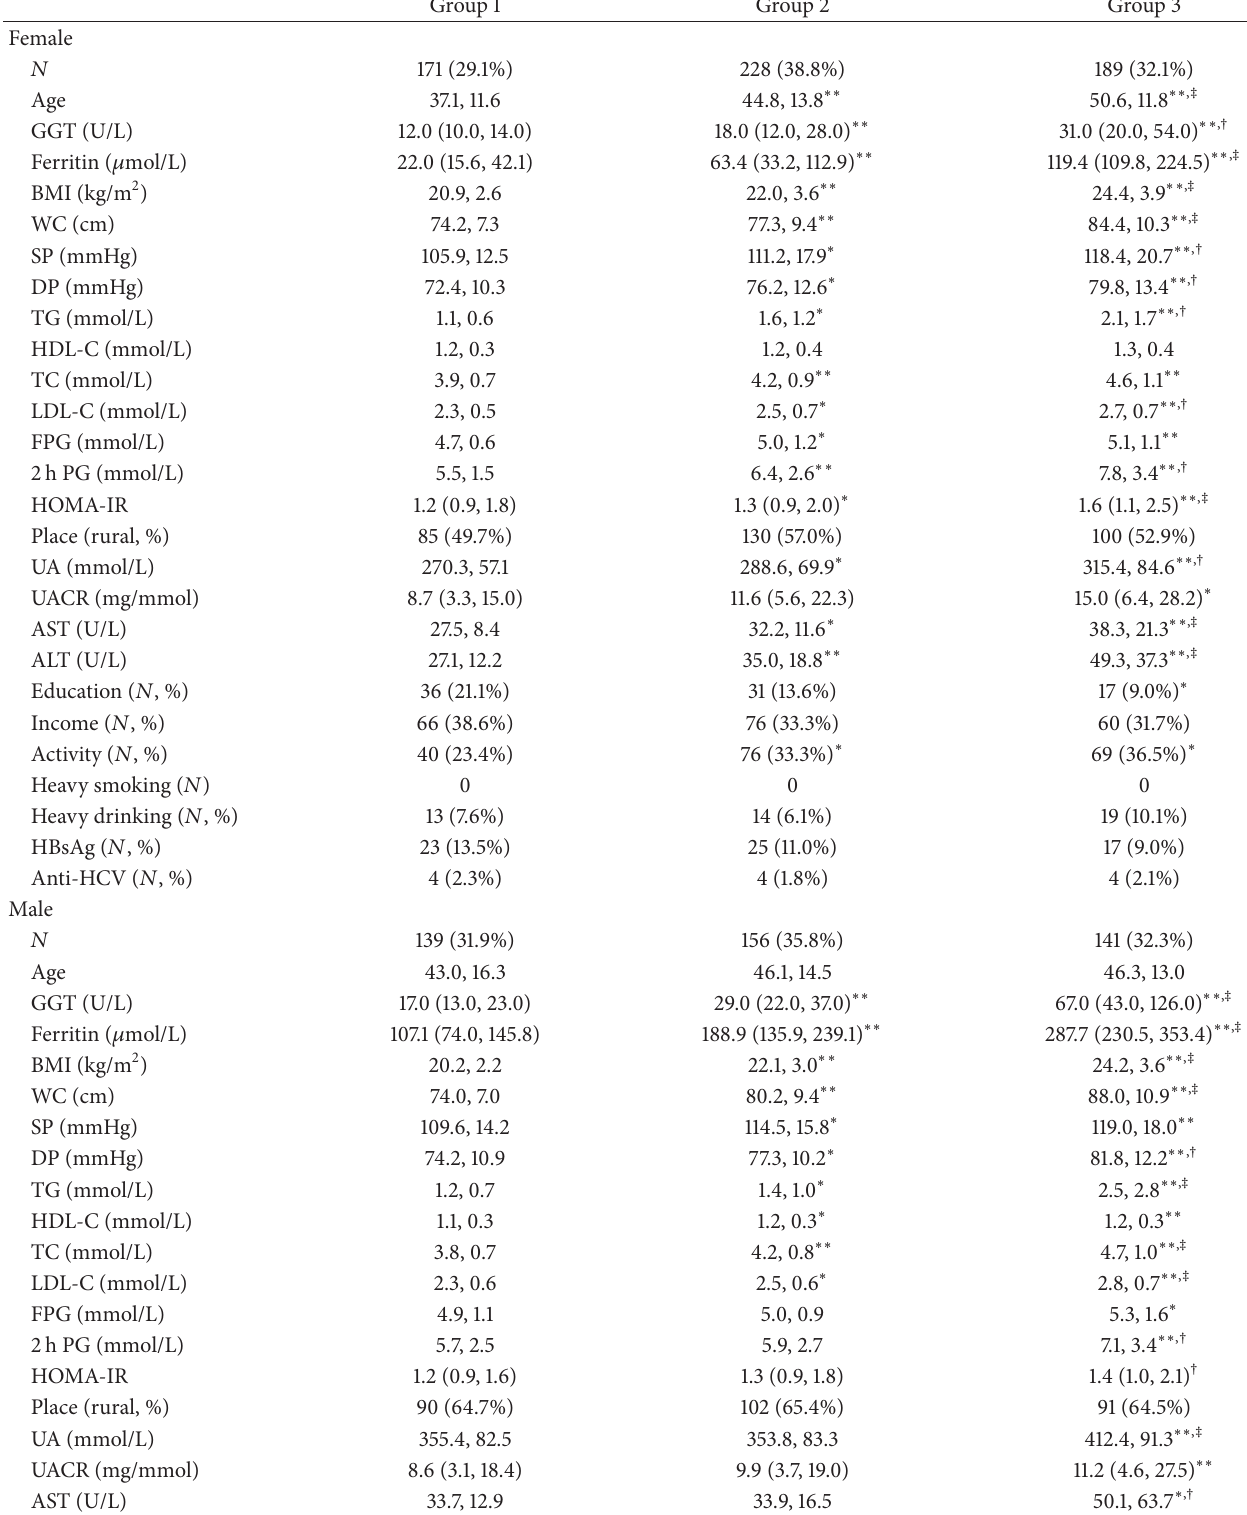
Table 2: Clinical and laboratory characteristics of subjects in groups defined by serum GGT and ferritin